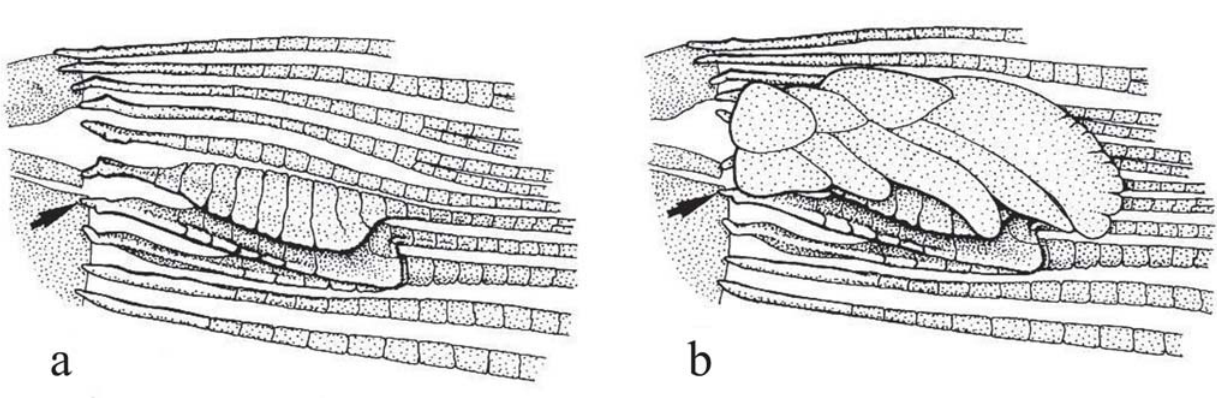
Fig. 67. Mimagoniates sylvicola , adult male, USNM 300364, 32.5 mm SL; osteology of central basal region of caudal-fin skeleton, principal fin rays 6-15, lateral view, left side, anterior at left. Principal caudal-fin ray 12 indicated by arrow. (a) Illustrates area of fully developed caudal organ. (b) Illustrates relationship of modified dorsal-fin squamation to pump chamber skeleton. Modified from Menezes & Weitzman (1990).